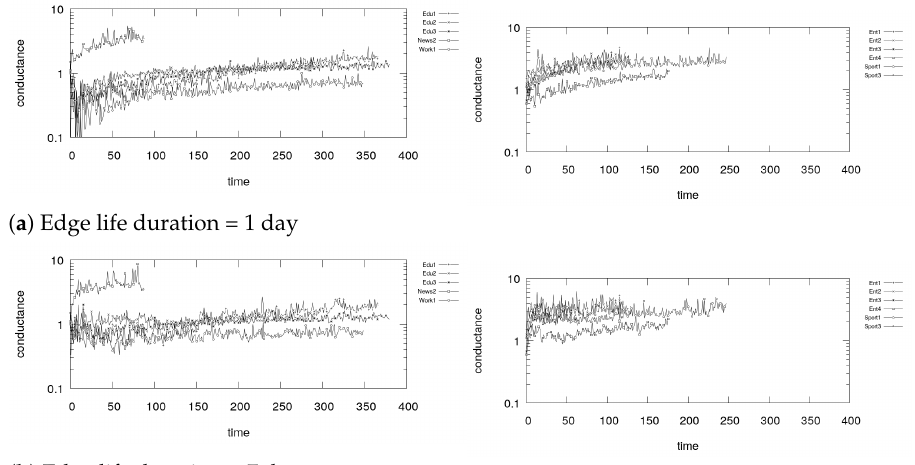
Figure 27. Conductance of communities detected by Fast Greedy.